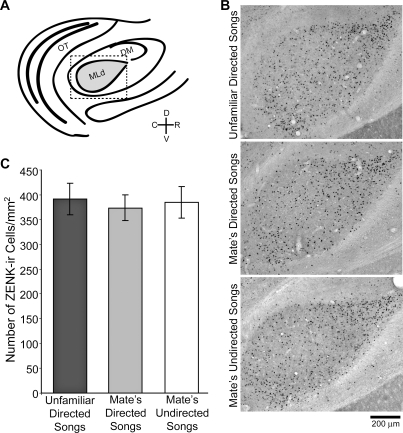
The Number of ZENK-Expressing Cells in the MLd Is Equally Increased by All Stimuli(A) Diagram of the region sampled within the MLd. Dashed line indicates the area shown in the images in (B). DM, dorsomedial nucleus of the intercollicular complex; OT, optic tectum.(B) Representative images of ZENK staining in the MLd in each of the stimulus groups.(C) Mean number of cells per area in the MLd. There were no significant differences between any of the groups in the number of ZENK expressing cells.